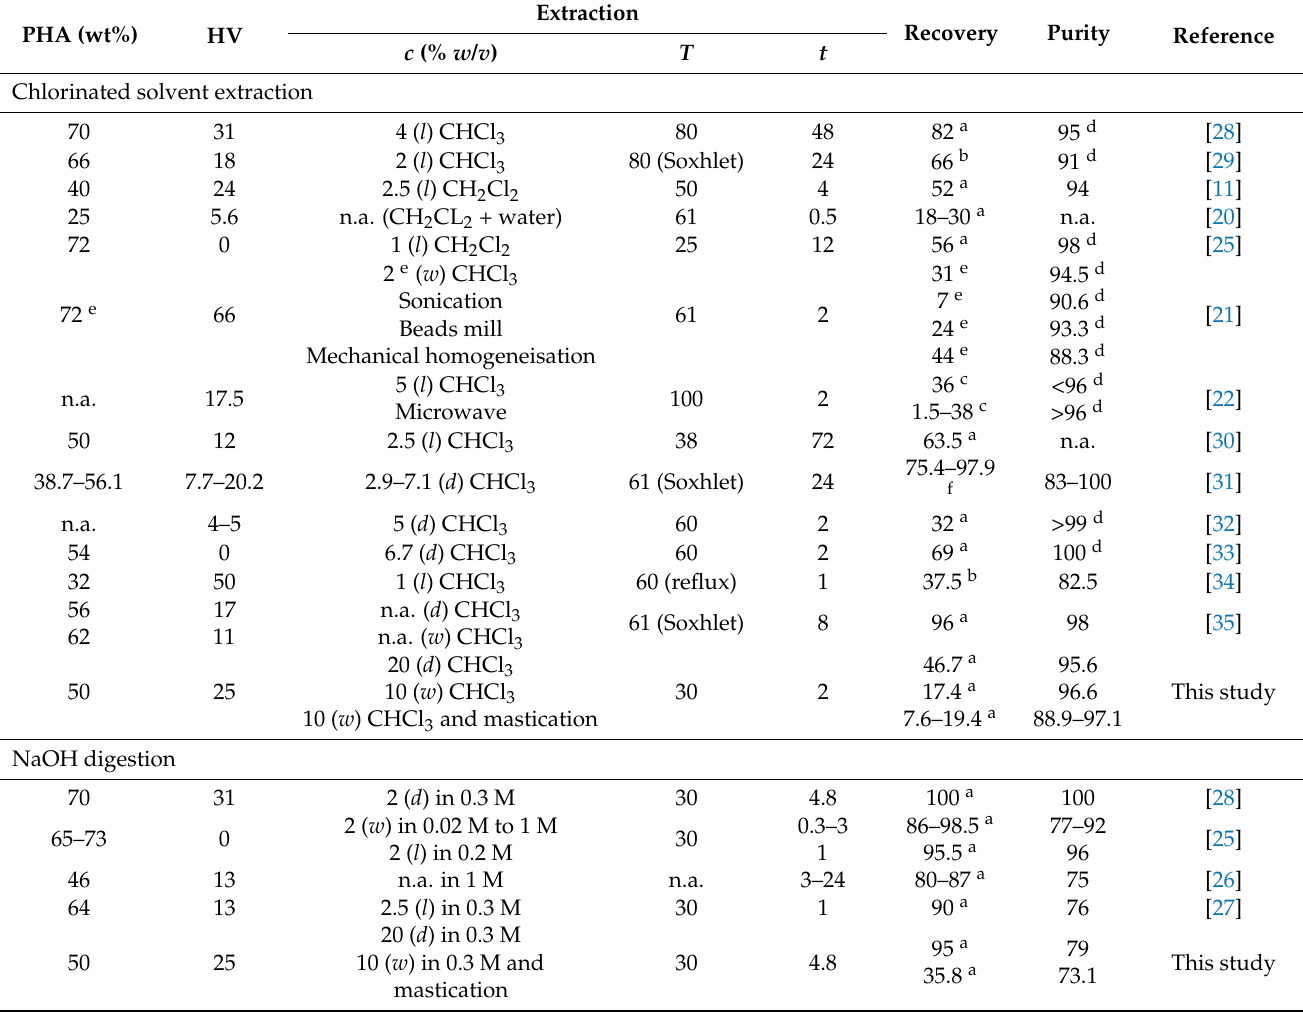
Table 1. Product recovery and PHA purity reported for the MMC PHA biomass downstreaming with chlorinated solvents or NaOH digestion. The PHA content (PHA) in the initial biomass is given in weight percent (wt%), and the proportion of 3-hydroxyvalerate (HV) in the recovered poly(3- hydroxybutyrate-co-3-hydroxyvalerates) (PHBV) is given in %. The concentration c of dry biomass in chloroform is given in weight per volume percent (% w / v ) in the corresponding solution (with CHCl 3 , CH 2 Cl 2 or NaOH with the corresponding molar concentration) and was computed from the reported type of biomass: dried ( d ), lyophylized ( l ) or wet ( w ), as computed from the referenced water content. The parameters of the downstreaming process are temperature ( T in ◦ C) and time ( t in hours). PHA recovery and purity are given in %. “n.a.” indicates data are not